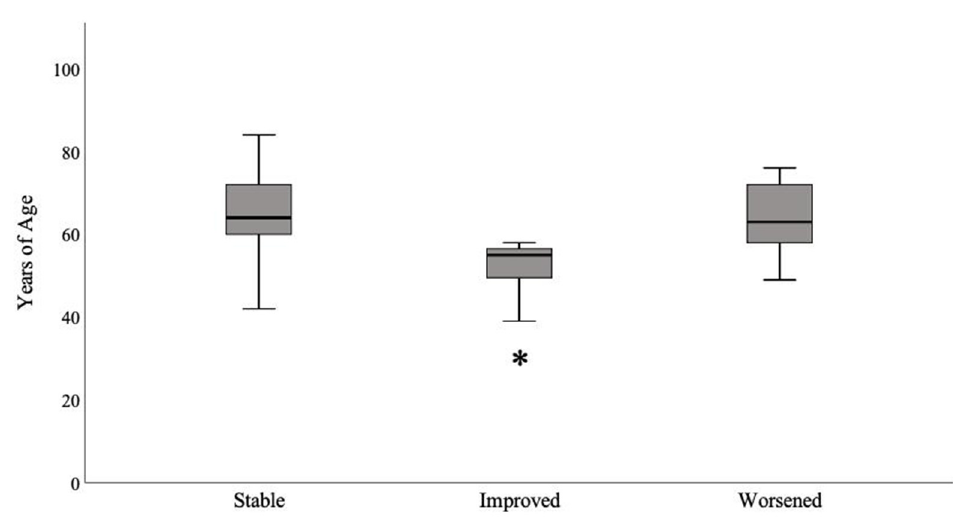
Figure 2. Box-plots showing the median age according to MG-ADL outcomes. Patients with MG- ADL improvement were younger compared to others (* p = 0.03). Median and interquartile ranges are reported. Table 1 summarize the demographic and clinical features of patients with MG-ADL score worsening after vaccination. Table 1. Clinical features of patients worsened at MGADL score after vaccination. AB, serum